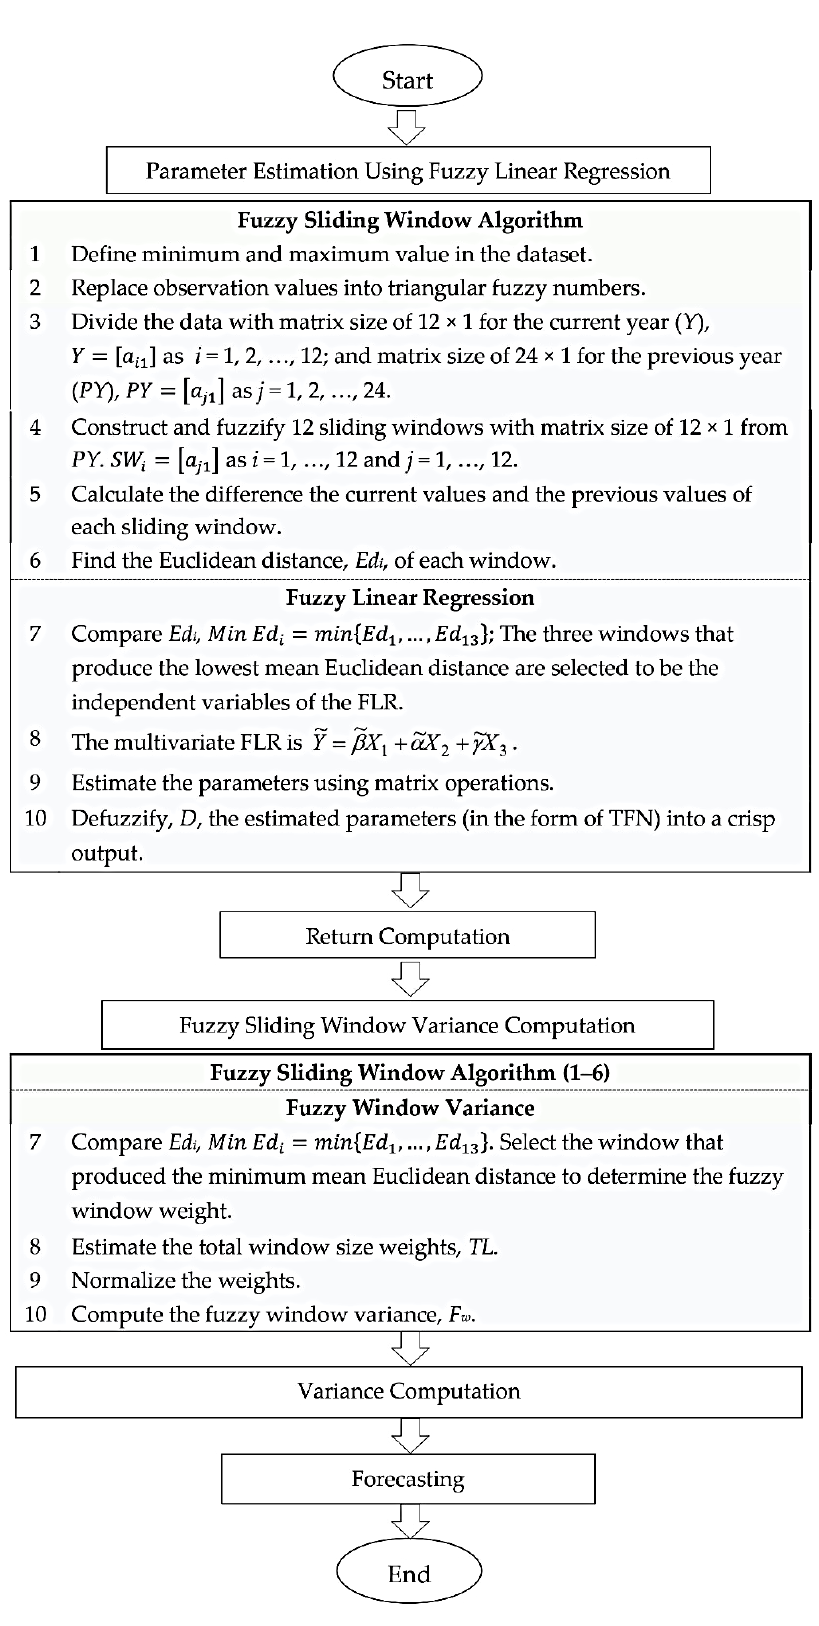
Figure 1. Design algorithm of the fuzzy linear regression sliding window generalized autoregressive conditional heteroskedasticity (FLR-FSWGARCH) model. TFN: triangular fuzzy number.